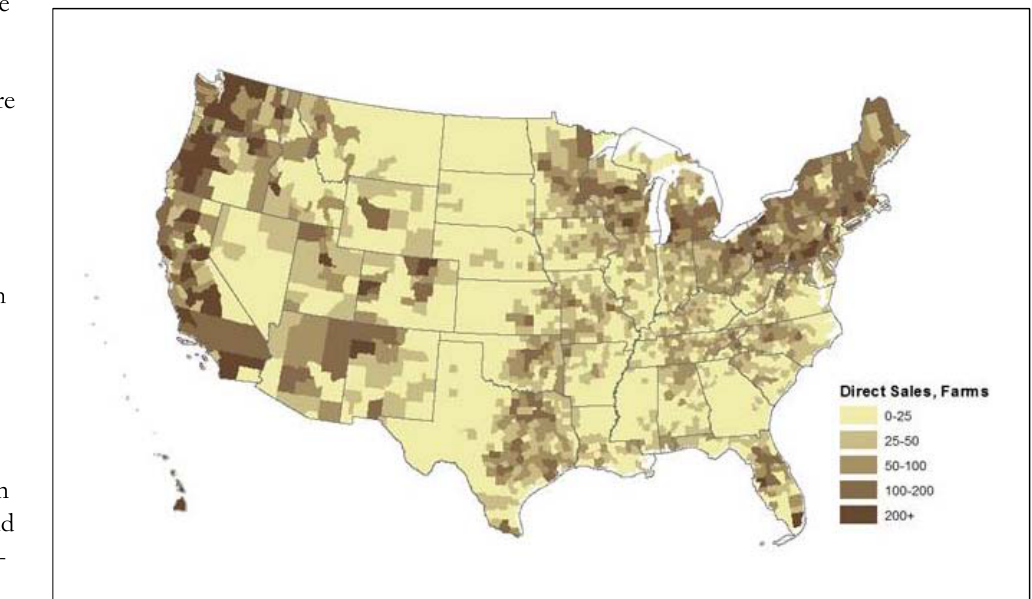
Figure 5. Spatial Distribution of Direct Marketing Farms,